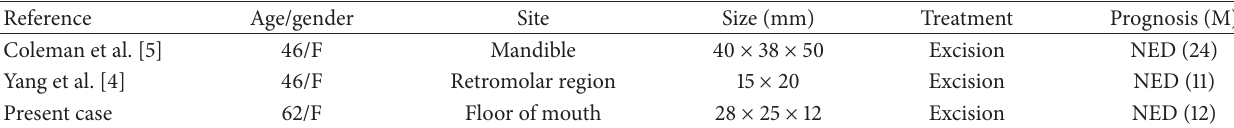
Table 1: Reported cases of oral typical carcinoid.